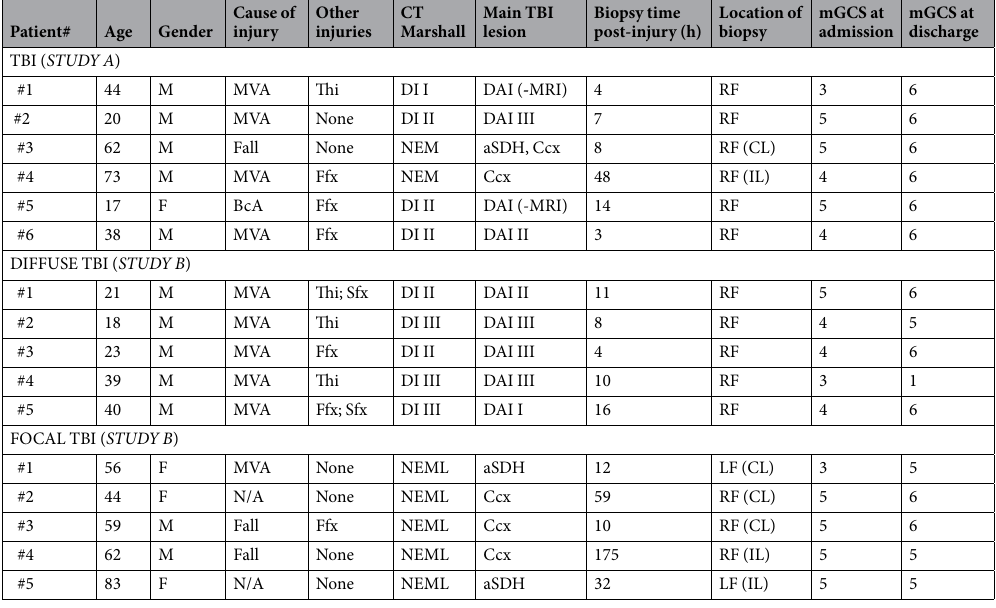
Table 1. Patient characteristics in STUDY A and B . M = male; F = female; mGCS; motor component of the Glasgow Coma Scale; MVA = motor-vehicle accident; BcA = bicycle accident; N/A = not established; Thi = thoracic injury; Ffx = facial fracture; Sfx = spinal fracture; DI = diffuse injury; NEML = non-evacuated mass lesion; DAI = diffuse axonal injury; aSDH = acute subdural hematoma; Ccx = Cortical contusion; - MRI = MRI not available; TBI = traumatic brain injury; RF = right frontal; LF = left frontal; CL = contralateral to focal lesion; IL = ipsilateral to focal